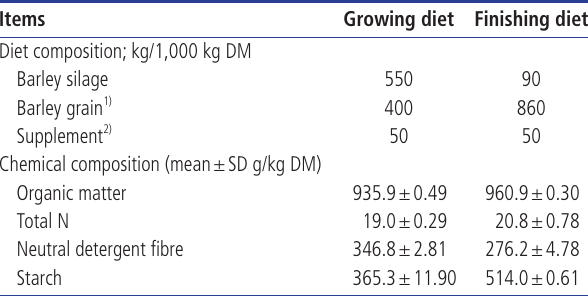
Table 4. Composition of total mixed rations fed to steers in feedlot experiment Items Growing diet Finishing